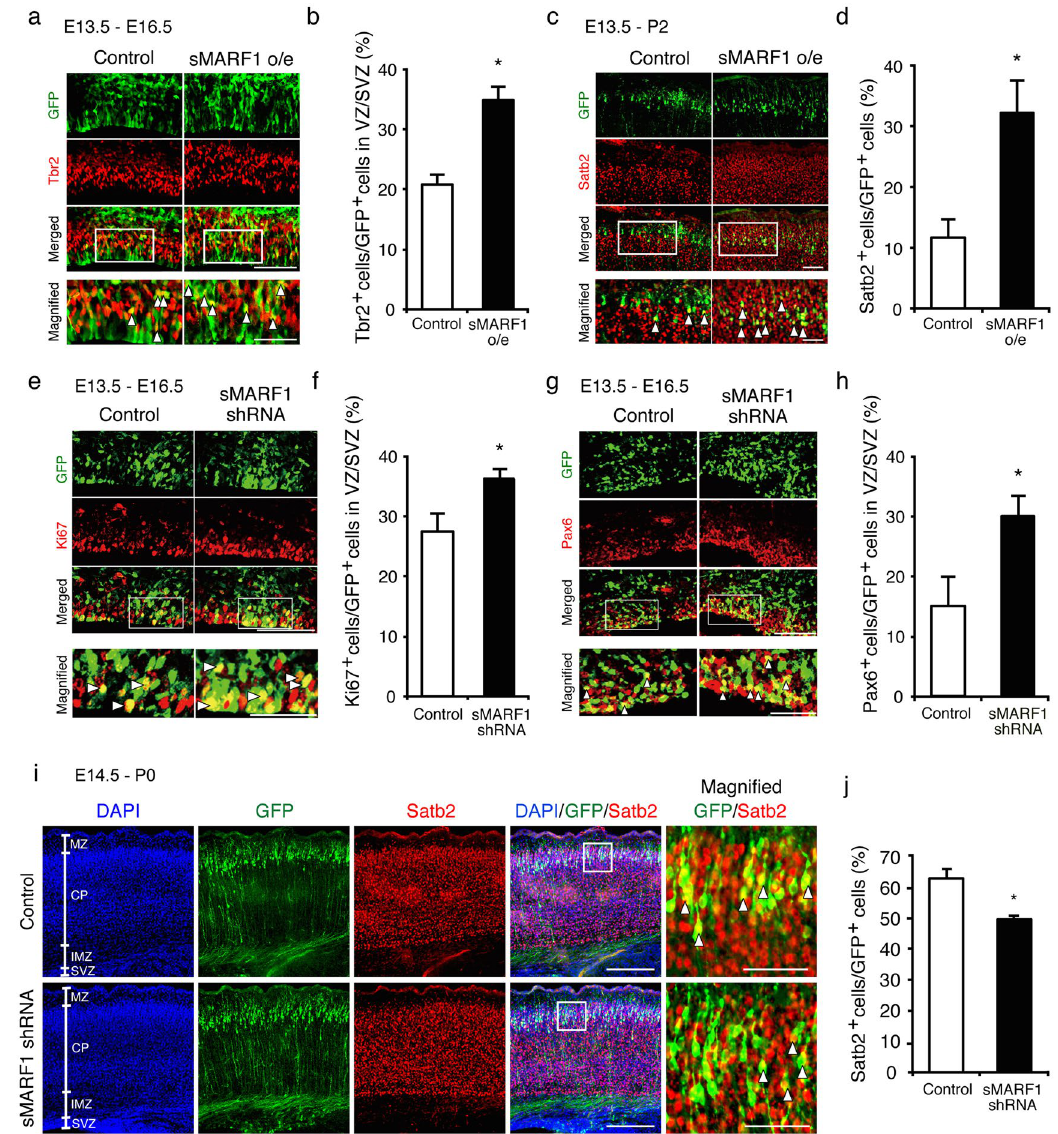
Figure 3. sMARF1 regulates cortical progenitor differentiation in vivo . ( a ) Immunostaining for GFP (green) and Tbr2 (red) at the SVZ in E16.5 mouse cortices 3 days after electroporation with pCAGIG (Control) or sMarf1 expression vector (sMARF1 o/e). White arrowheads indicate GFP-labeled Tbr2 + basal progenitor cells. Scale bar, 100 μ m in the merged image, 50 μ m in the magnified image. ( b ) Quantification of GFP-labeled Tbr2 + cells in the VZ and SVZ (VZ/SVZ). * p < 0.05 (n = 3, Student’s t -test). ( c ) Immunostaining for GFP (green) and Satb2 (red) at the upper-layer of postnatal day 2 mouse cortices 7 days after electroporation with pCAGIG (Control) or sMarf1 expression vector (sMARF1 o/e). White arrowheads indicate GFP-labeled Satb2 + upper- layer neurons. Scale bar, 400 μ m in the merged image, 200 μ m in the magnified image. ( d ) Quantification of GFP-labeled Satb2 + cells in the upper-layer cortex. * p < 0.05 (n = 3, Student’s t -test). ( e ) Immunostaining for GFP (green) and Ki67 (red) in the SVZ of E16.5 mouse cortices 3 days after electroporation with scrambled (Control) or Marf1 -specific shRNA vector (sMARF1 shRNA). White arrowheads indicate GFP-labeled Ki67 + cells. Scale bar, 100 μ m in the merged image, 50 μ m in the magnified image. ( f ) Quantification of GFP-labeled Ki67 + cells in the VZ/SVZ. * p < 0.05 (n = 3, Student’s t -test). ( g ) Immunostaining for GFP (green) and Pax6 (red) at the SVZ in E16.5 mouse cortices 3 days after electroporation with scrambled (Control) or Marf1 - specific shRNA vector (sMARF1 shRNA). White arrowheads indicate GFP-labeled Pax6 + radial glia. Scale bar, 100 μ m in the merged image, 50 μ m in the magnified image. ( h ) Quantification of GFP-labeled Pax6 + cells in the VZ/SVZ. * p < 0.05 (n = 3, Student’s t -test). ( i ) Immunostaining for GFP (green) and Satb2 (red) at the upper- layer of postnatal day 0 mouse cortices 5 days after electroporation with scrambled (Control) or Marf1 -specific shRNA vector (sMARF1 shRNA). White arrowheads indicate GFP-labeled Satb2 + upper-layer neurons. Scale bar, 200 μ m in the merged image, 50 μ m in the magnified image. MZ: marginal zone, CP: cortical plate, IMZ: intermediate zone, SVZ: subventricular zone ( j ) Quantification of GFP-labeled Satb2 + cells in the upper-layer cortex. * p < 0.05 (n = 3, Student’s t